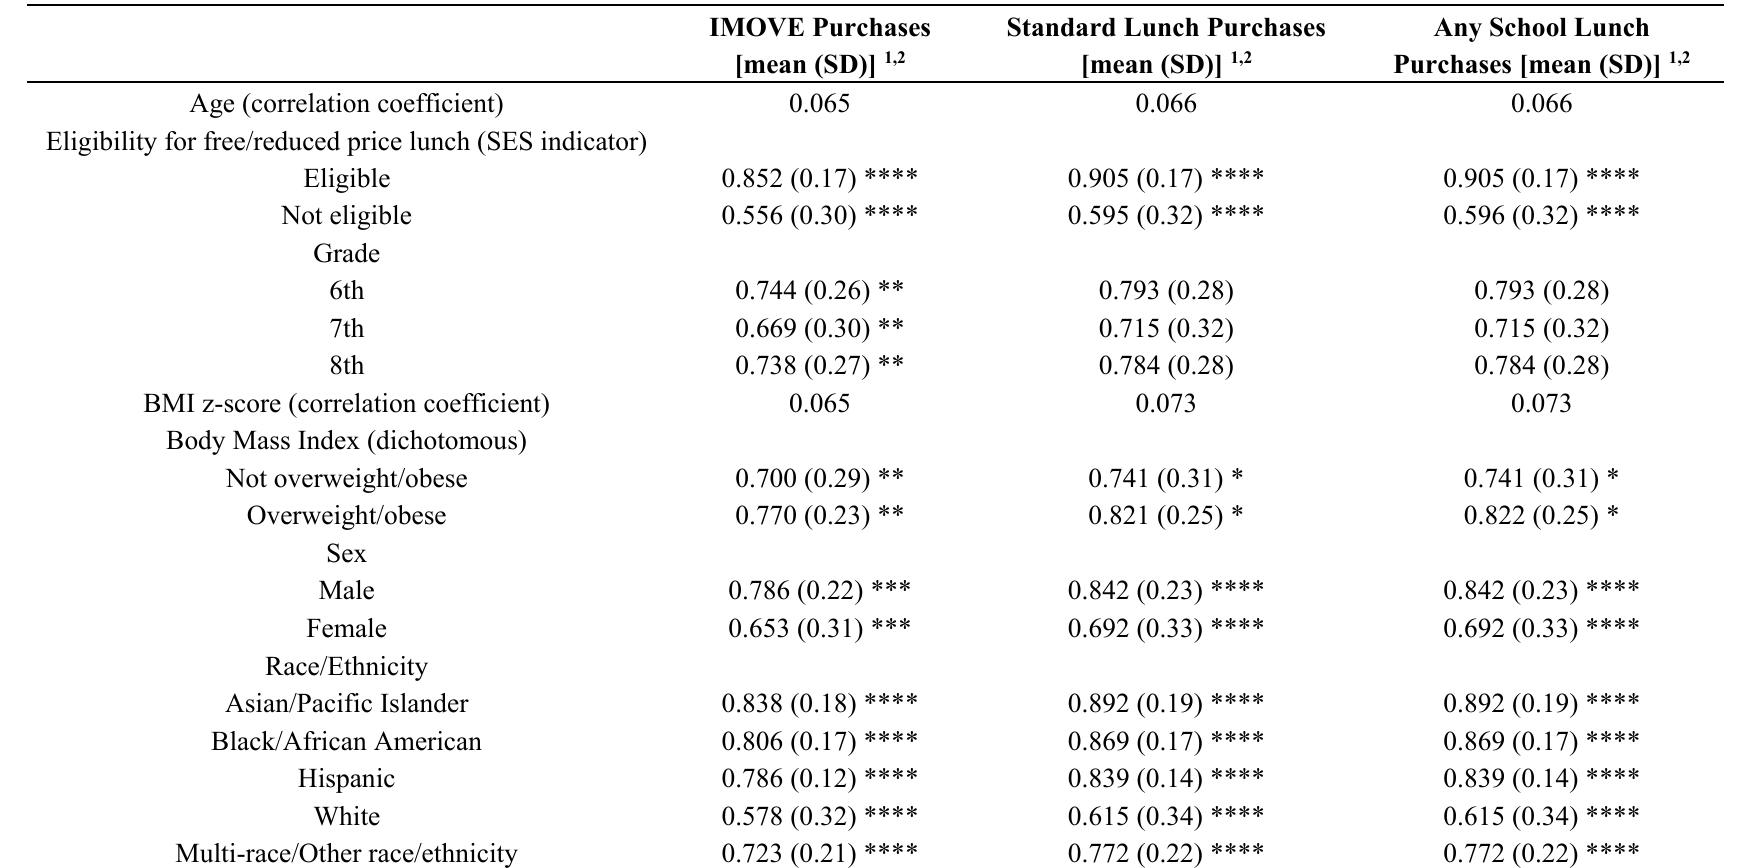
Table 3. Unadjusted Mean Purchase Rates for IMOVE Lunch, Standard School Lunch, and Any School Lunch by Participant Characteristics ( n =